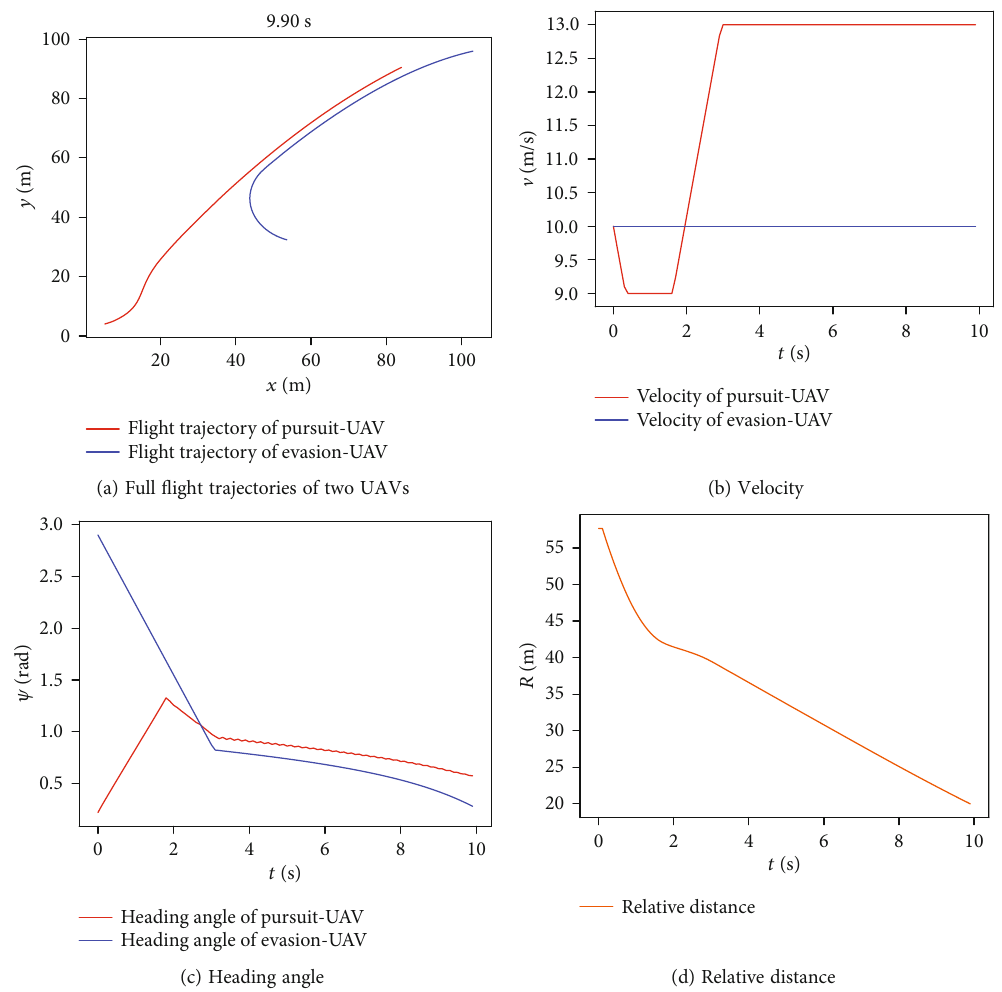
Figure 10: Flight trajectories and test results using